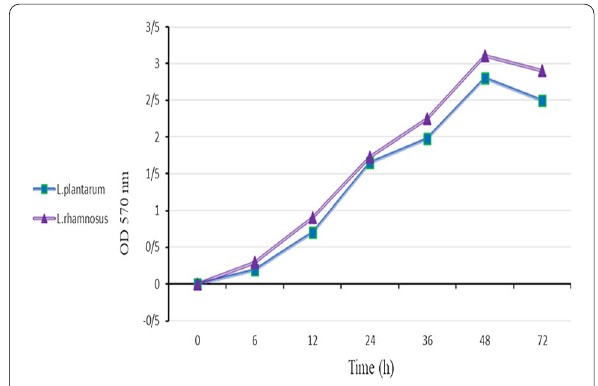
Fig. 1 The ability of biofilm formation over time